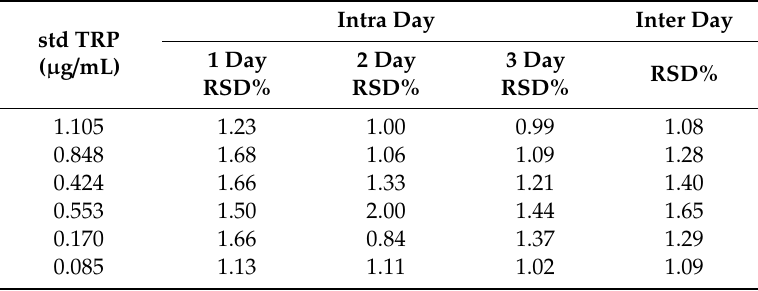
Table 2. Repeatability and reproducibility performances on pure standards.